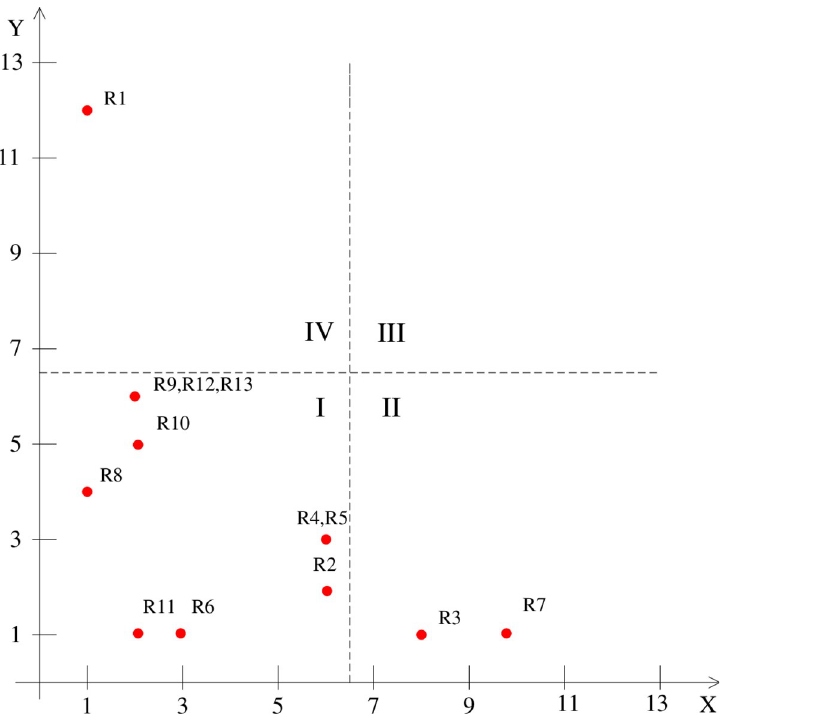
Fig 2. Classification of the risk factors’ dependence-driving